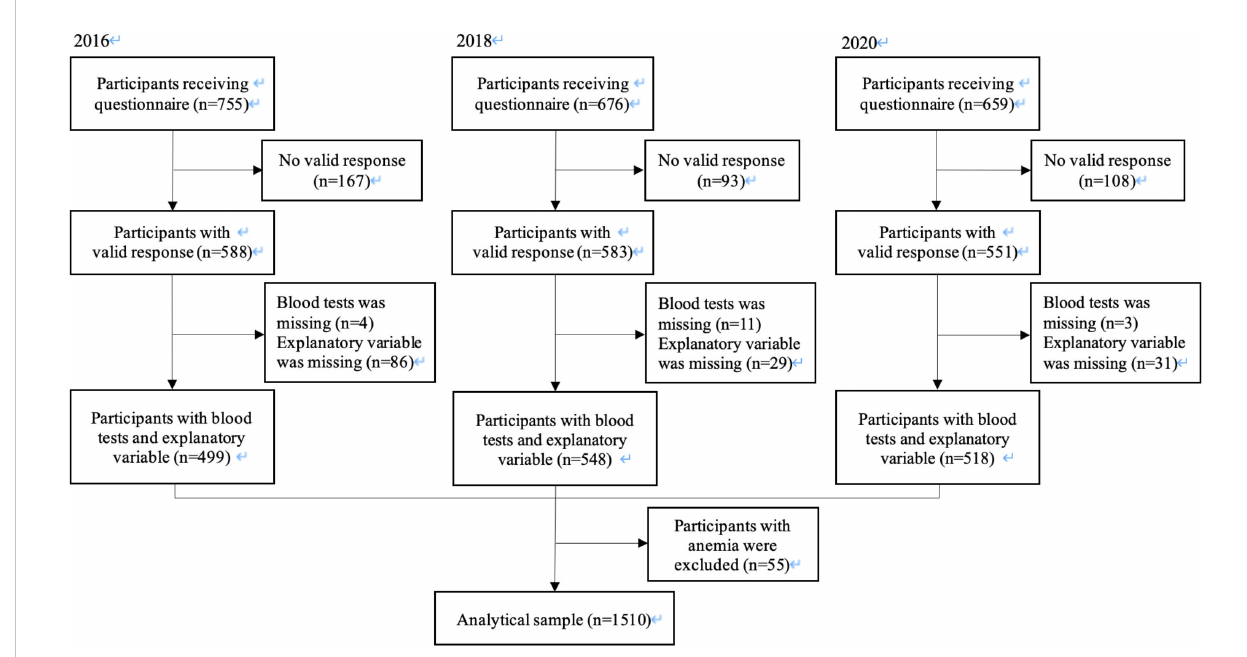
FIGURE 1 Participant fl ow chart. Of the 2090 2nd year students in seven representative junior high schools in Adachi City in 2016, 2018 and 2020, we analyzed 1510 students, who provided data for the frequency of breakfast and the blood